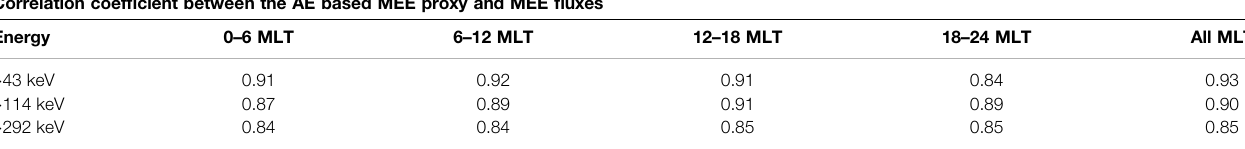
TABLE 3 | The Pearson correlation coef fi cient between daily resolved AE based MEE proxy and the logarithmic value of > 43, > 114, and > 292 keV loss cone fl uxes over the 55 ° – 70 ° CGM latitude band for the years 2004 – 2014. Correlation coef fi cient between the AE based MEE proxy and MEE fl uxes